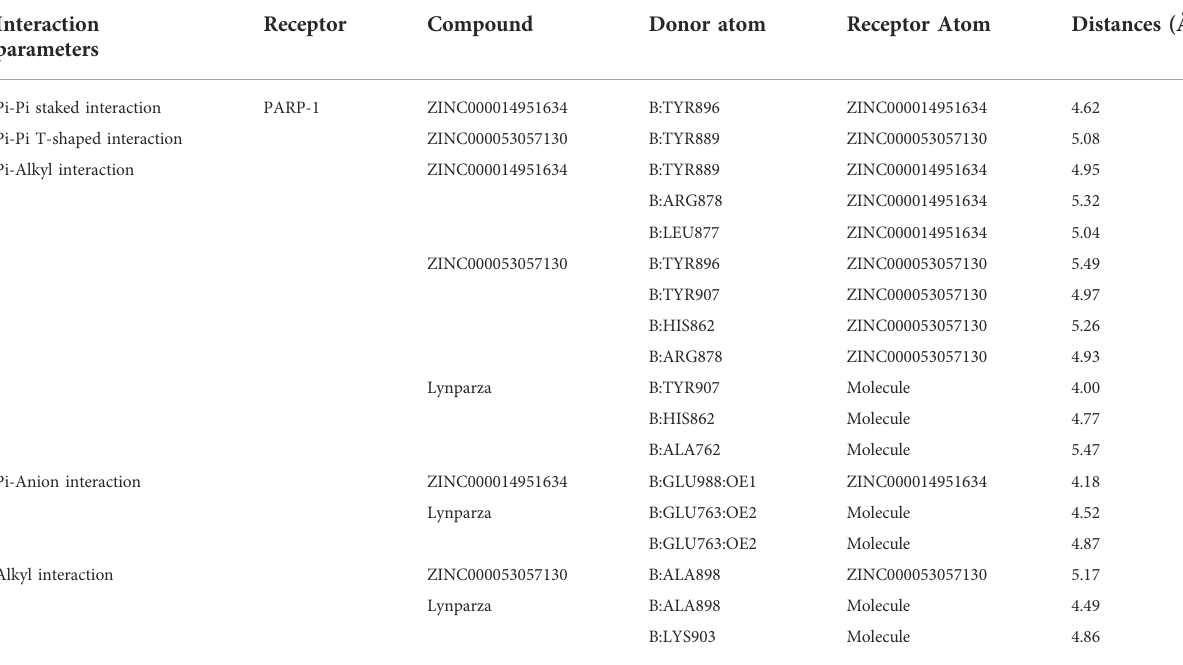
TABLE 6 Pi-Pi interaction, Pi-Alkyl interaction, Pi-Anion interaction and Alkyl interaction parameters for each compound and PARP-1 residues. Interaction parameters